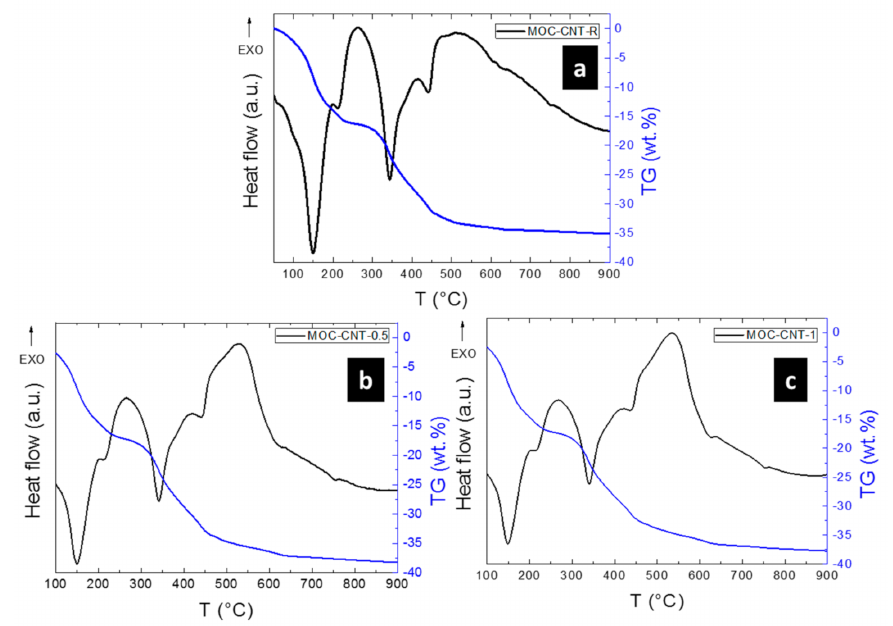
Figure 5. STA of ( a ) MOC-CNT-R, ( b ) MOC-CNT-0.5, and ( c )